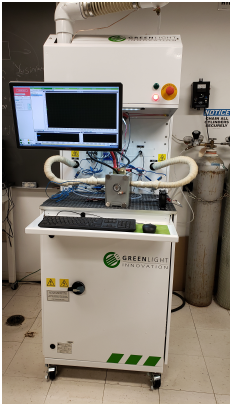
Figure 1. Greenlight G60 testing station.